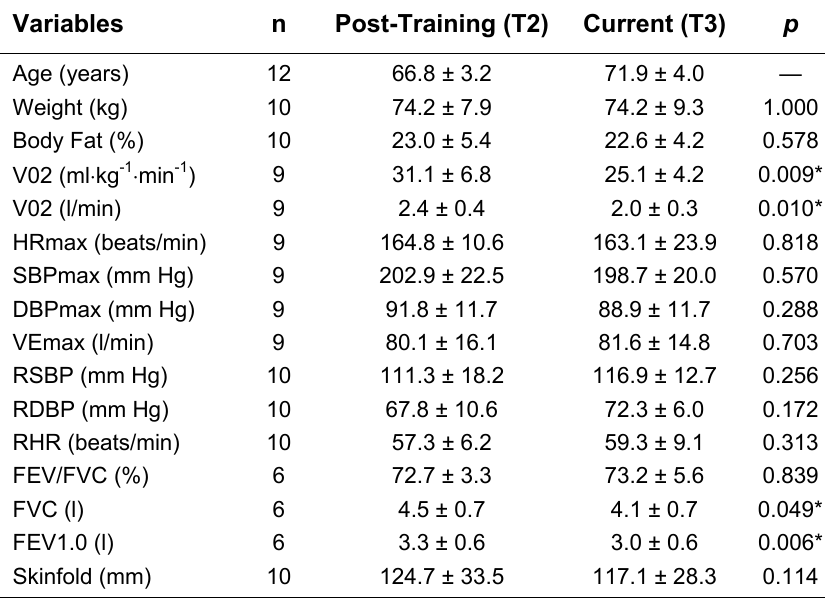
Post-Training and Current Measurements for Highly Active Subjects